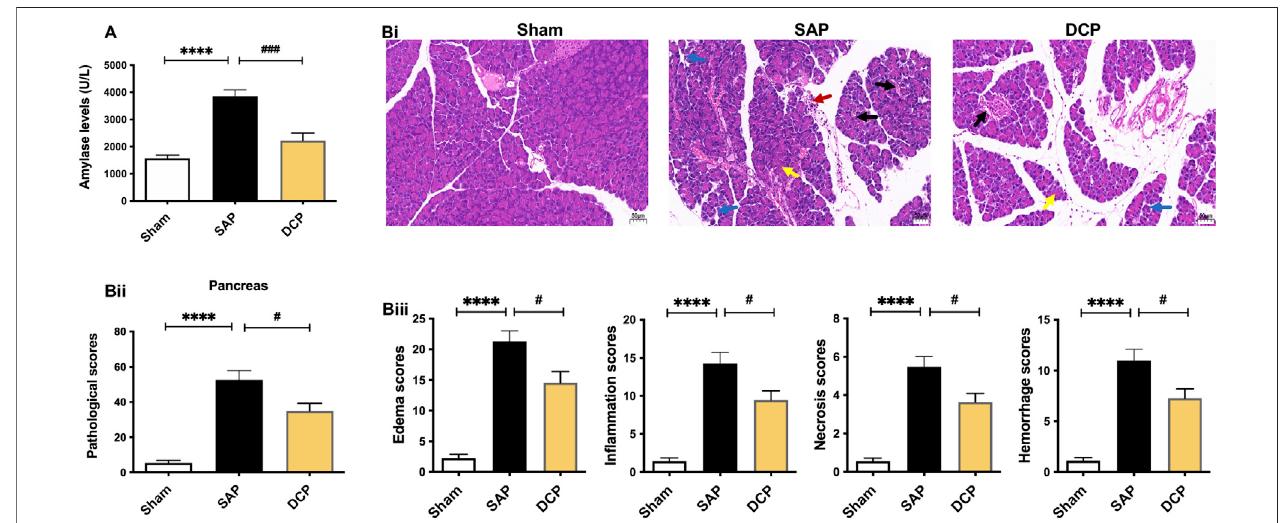
FIGURE 1 | DCP attenuated the pathological damage of pancreatic tissues in rats with SAP. (A) : Serum amylase levels in Sham, SAP and DCP group; (Bi) : RepresentativepathologicalimagesofH&Estainingonpancreatic tissues(×200),arrows (blue,red,yellow,black) indicatedpancreatic edema,in fl ammation,necrosis, and hemorrhage respectively; (Bii) : Total pathological scores of the pancreatic tissues of each group. (Biii) : Histological scores of edema, in fl ammation, necrosis and hemorrhageofpancreasineachgroup.Theresultsarepresentedasthemean±SEM.**** p < 0.0001vs.shamgroup, # p < 0.05, ### p < 0.005vs.SAPgroup;ns, p > 0.05. sham: sham operation group; SAP: Sever acute pancreatitis group; DCP: Dao-Chi powder treatment